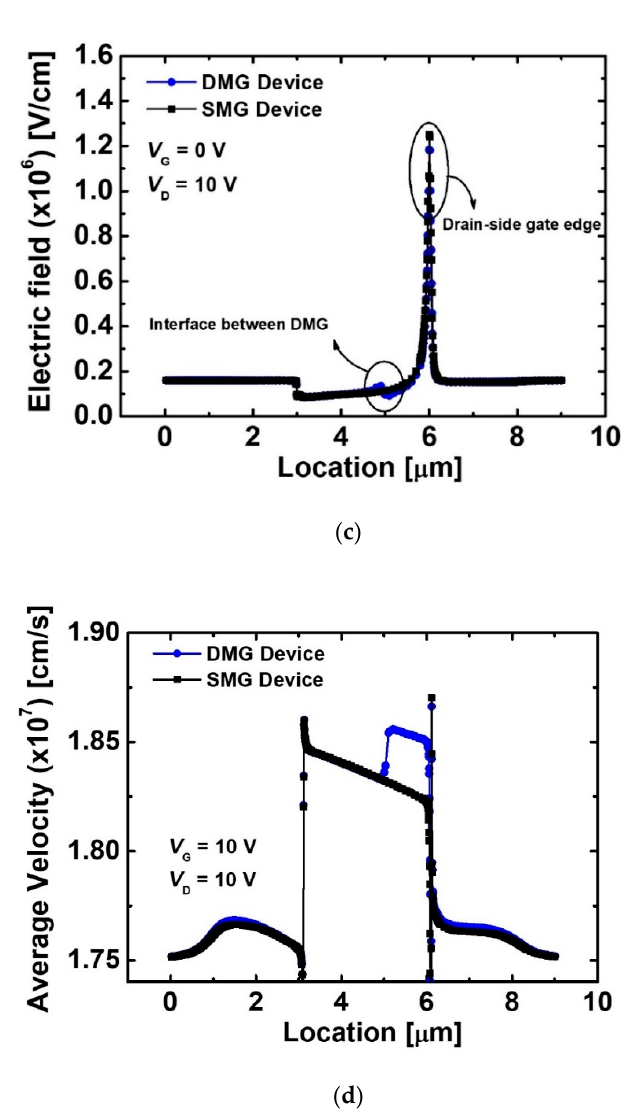
Figure 3. Technology computer-aided design (TCAD) simulated results of the devices with the SMG (Ni) and DMG (Ni-Ti) structures. ( a ) Electron density at zero bias, ( b ) energy band diagrams at the off-state, ( c ) electric field at the off-state, and ( d ) electron velocity at the on-state. The total L G of the SMG- and DMG-based devices was 3 μ m. The L M1 and L M2 of the DMG-based device are 2 μ m and 1 μ m, respectively.